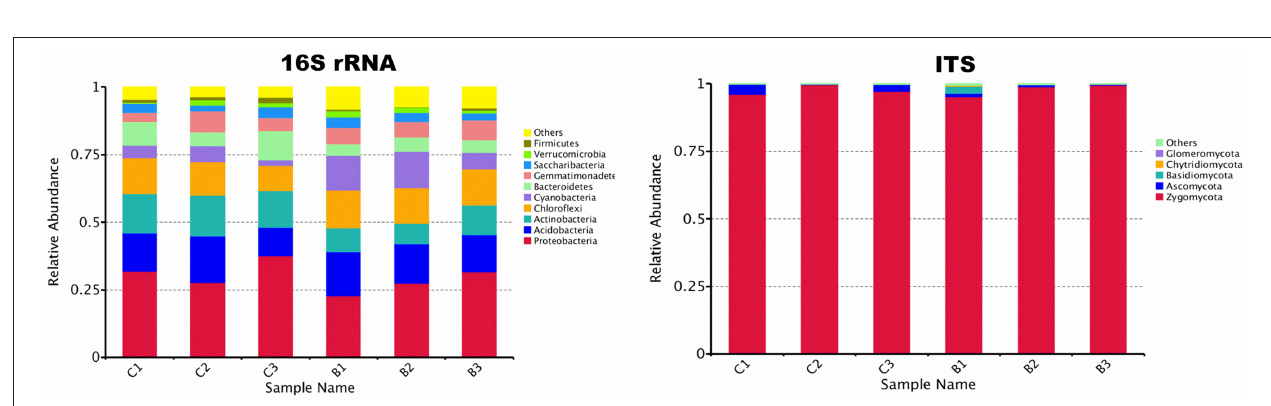
FIGURE 3 | Relative abundance of bacterial and fungal phylum; B: Intercrop, C: Monoculture (C1, C2, C3 and B1, B2, B3 are the replicates of monoculture and intercrop treatments).